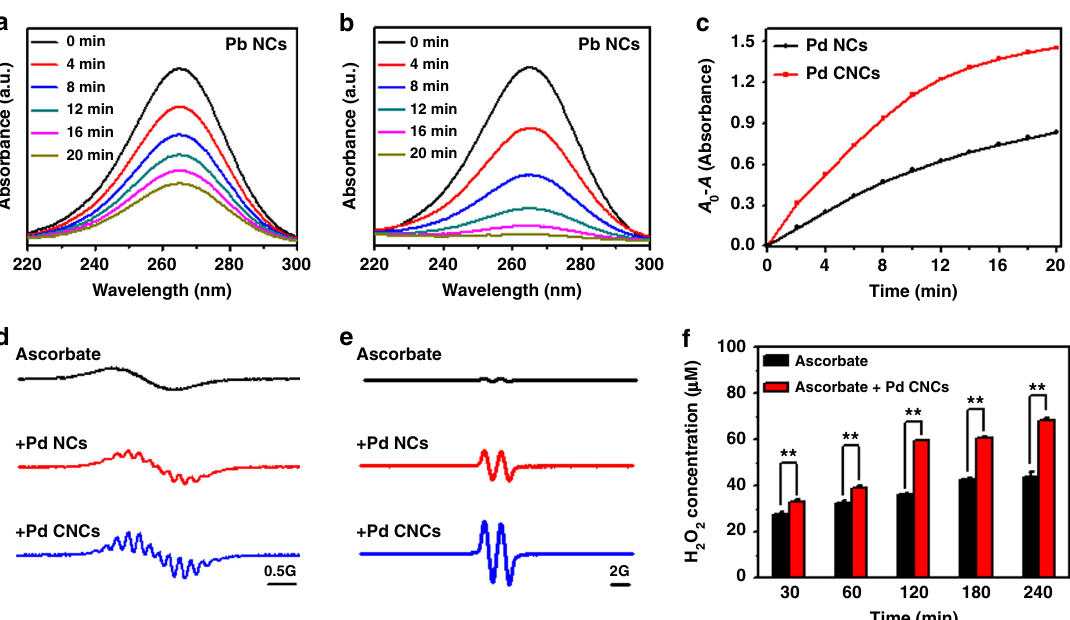
Fig. 2 Oxidation of ascorbate catalyzed by Pd nanocrystals. a , b Evolution of UV- vis absorption spectra for 100 μ M ascorbate with 50 μ g/mL Pd nanocubes (Pd NCs) or Pd concave nanocubes (Pd CNCs) in aqueous solution. c Time-dependent absorbance changes of ascorbate at 265 nm with Pd NCs or Pd CNCs. d Oxygen consumption during oxidation of ascorbate. ESR spectra of 0.1 mM CTPO obtained from samples containing 5 mM ascorbate in the absence and presence of 50 μ g/mL Pd nanocrystals at 10 min. e Ascorbic radical production. ESR spectra were collected at 2 min after mixing 5 mM ascorbate with or without 50 μ g/mL Pd nanocrystals. f The concentration of H 2 O 2 with ascorbate alone, or the combination of ascorbate and Pd CNCs. The numerical data are expressed as the mean ± standard deviation. Error bars were taken from three parallel experiments ( n = 3). P values compared to that of corresponding ascorbate alone treatment were calculated by Student´s t -test: ** p <